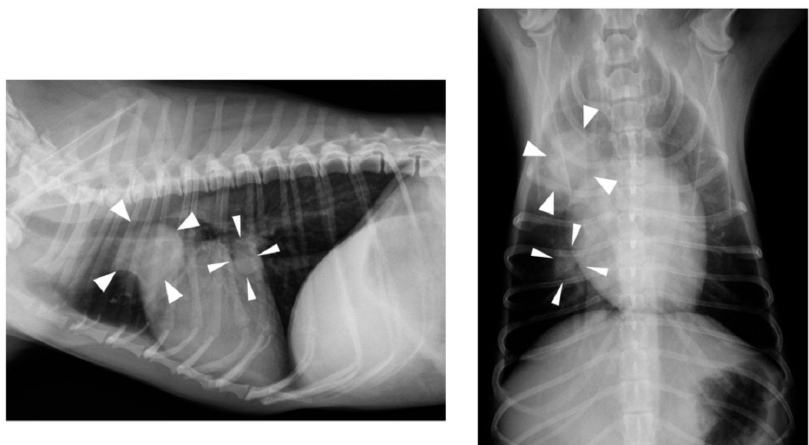
Figure 2. Thoracic radiography findings on day 404. Nodular lesions (arrow heads) were detected in the cranial and middle lobe of the right